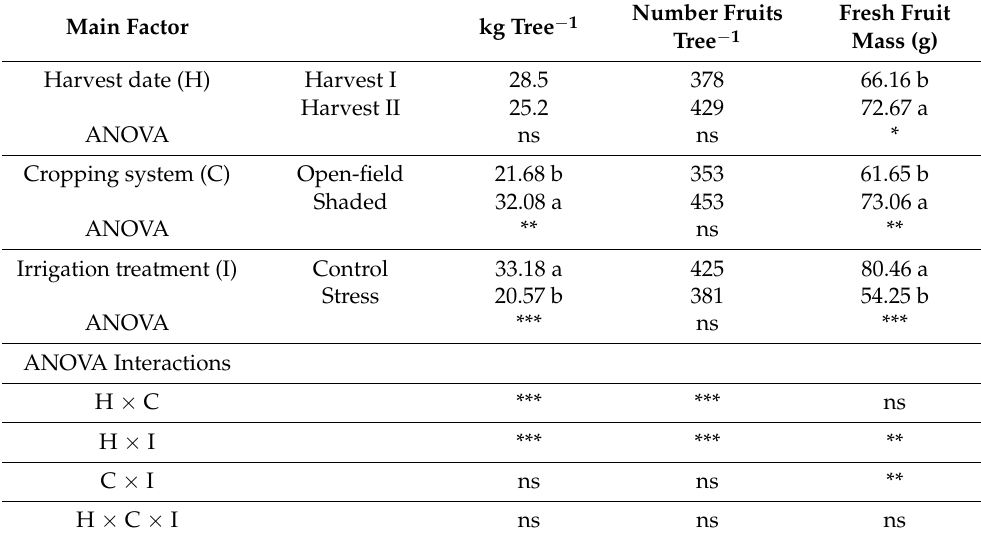
Fresh Fruit Number Fruits Mass (g) Tree − 1